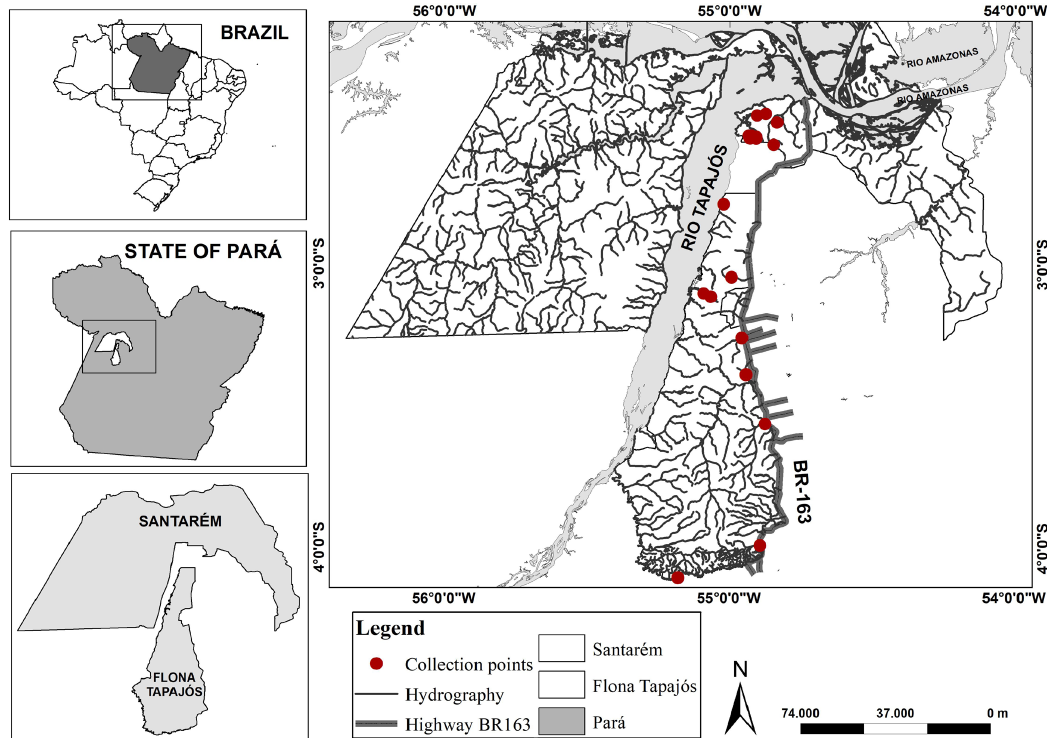
Figure 1. Location of the study streams in which the Phylloicus populations were surveyed in western Pará,